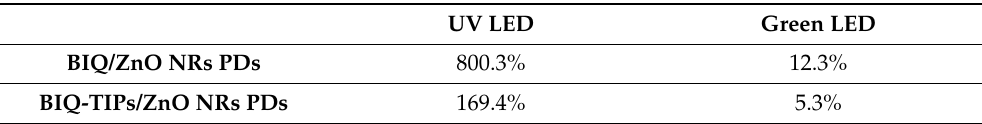
Table 2. Comparison of photosensitivity of BIQ/ZnO NRs and BIQ-TIPs/ZnO NRs devices under UV and green LED